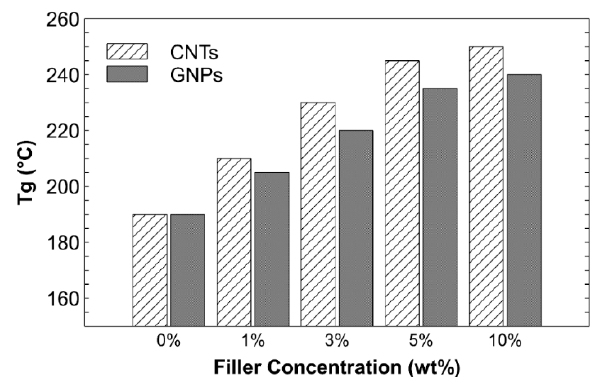
Figure 8. Effect of adding CNTs and GNPs on glass transition temperatures (T g ) of composites.